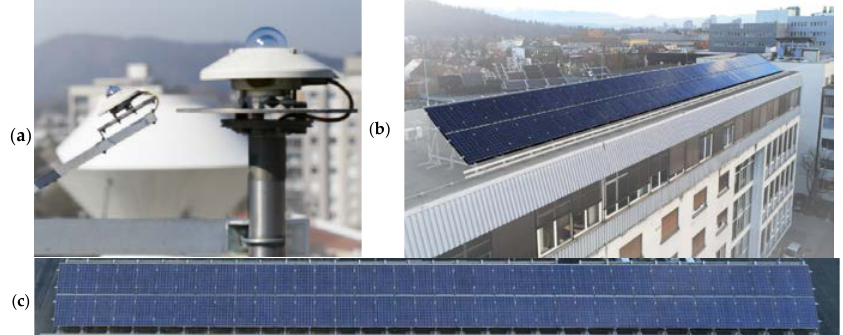
Figure 2. Images of the 17 kW Photovoltaic (PV) system installed on the rooftop of the Faculty of Electrical Engineering, University of Ljubljana, Slovenia. ( a ) Pyranometers installed at the Plane-of-Array and horizontal. ( b ) PV system from a perspective showing the building where installed. ( c ) The PV system from a perpendicular angle.